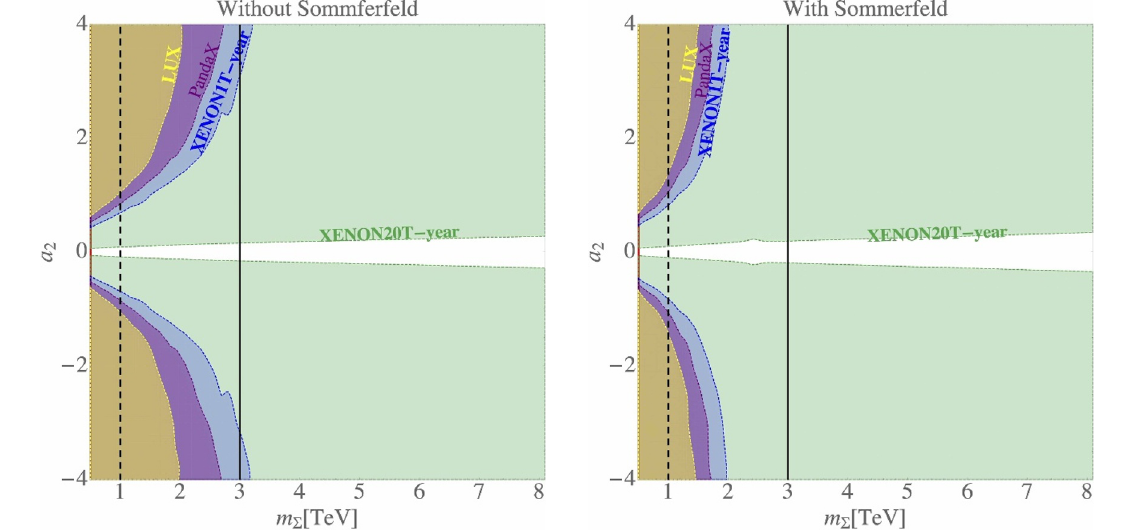
Figure 8 . Scaled spin-independent cross section σ scaled on the a 2 – m Σ plane. Left panel: exclusion SI regions when the Sommerfeld effect is not included, where the yellow region is the constraint from LUX [73], purple from PandaX-II [74], blue from XENON1T [75] and green from the projected XENON20T. The vertical lines have the same meaning as in figure 6. 16 Right panel: same as the left but with the Sommerfeld effect